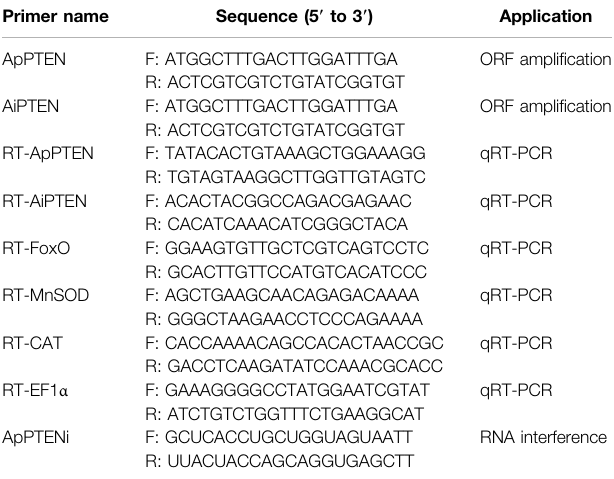
TABLE 1 | Primers used for in the present